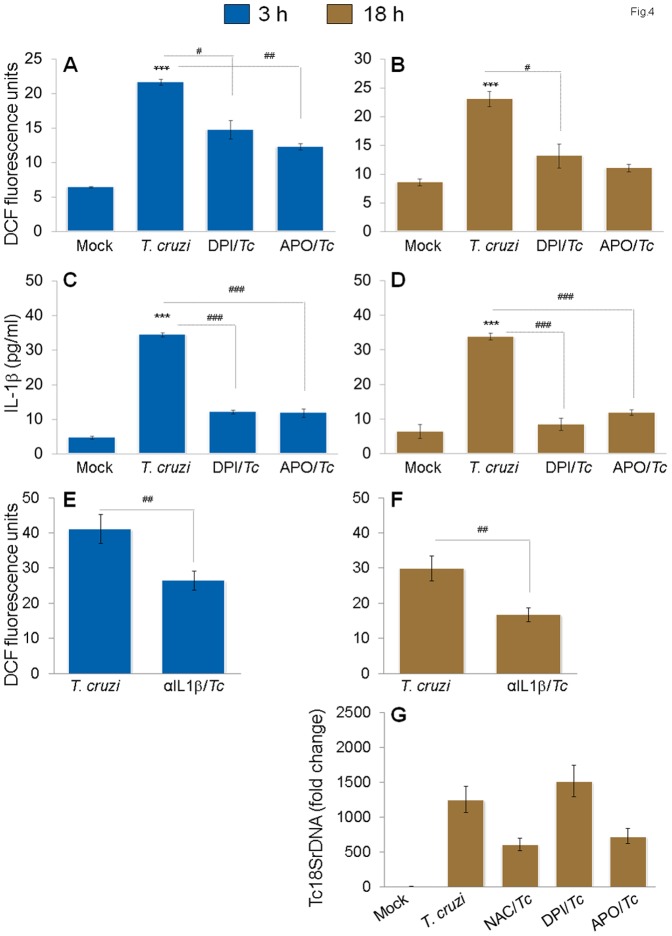
Feedback cycle of NOX2/ROS and IL-1β activation in mφs infected by T. cruzi.THP-1 mφs were infected with T. cruzi as in Fig. 1, and incubated for 3 h (A,C,E) or 18 h (B,D,F,G) in presence of NOX2 inhibitors (diphenylene iodinium (DPI) or apoCynin), ROS scavenger (N-acetylcysteine (NAC)) or IL-1β antibody. (A–D) NOX2 inhibitors decreased ROS and IL-1β levels in infected mφs. Shown are (A&B) H2DCFDA oxidation by intracellular ROS, resulting in formation of fluorescent DCF by fluorimetry and (C&D) IL-1β release in supernatants determined by an ELISA. (E&F) Treatment with anti-IL-1β antibody decreased the ROS levels in infected mφs. (G) Effect of ROS inhibitors on intracellular parasite burden, as determined by qPCR, in infected mφs.